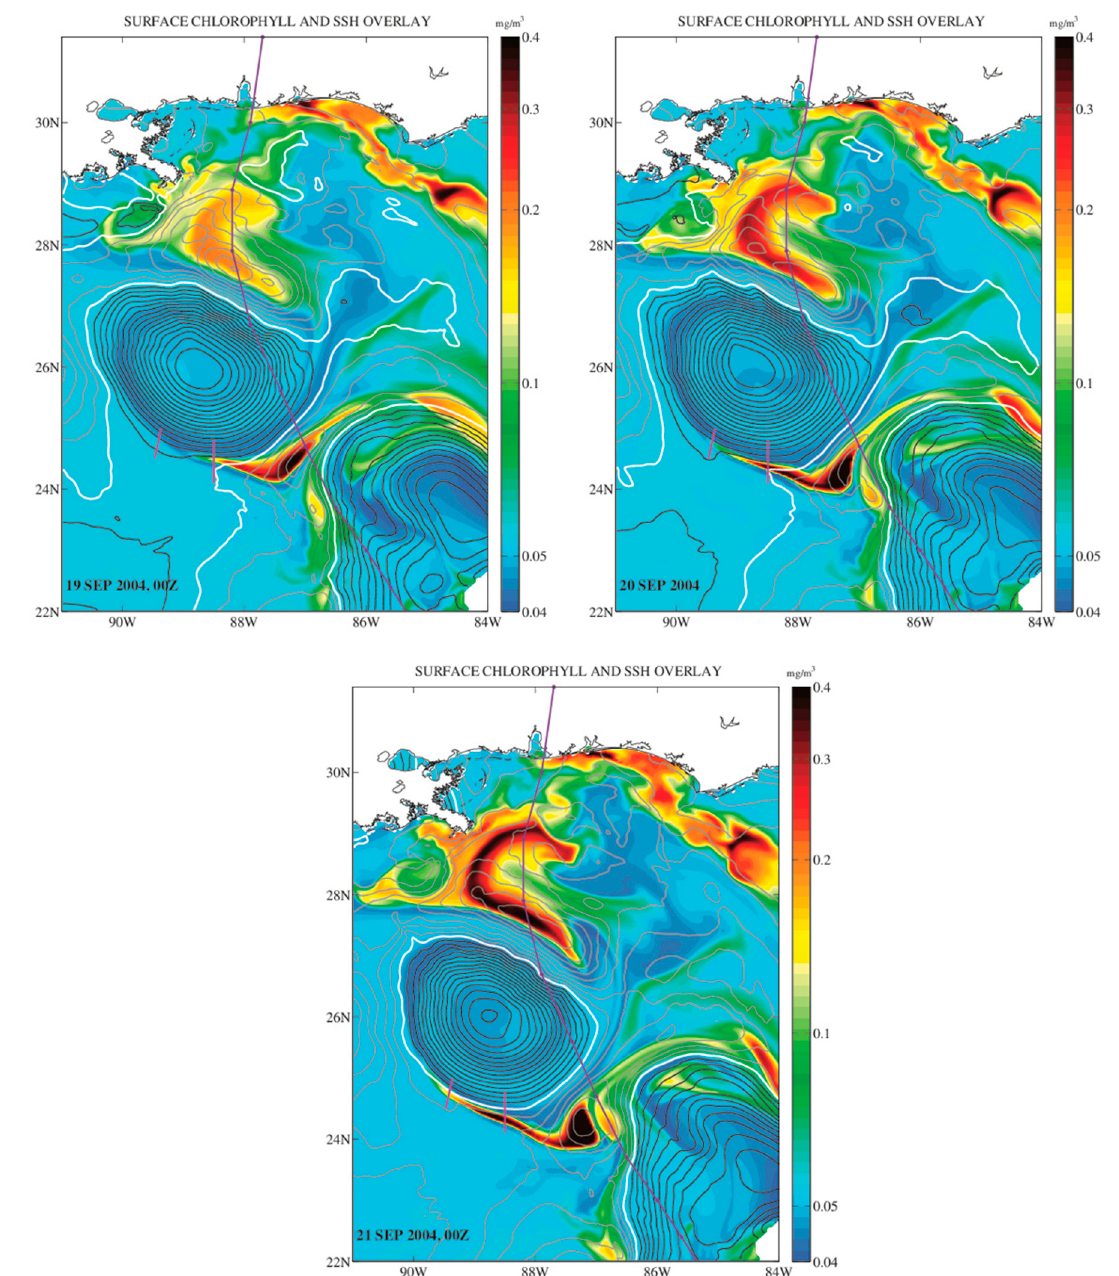
Figure 8. Simulated surface chlorophyll on 0000 UTC September 19–21. Simulated SSH is overlain in solid contours. Cross-section plots (Figures 6, 7, and 9) correspond to lines shown across the filament on the southern edge of the WCE.